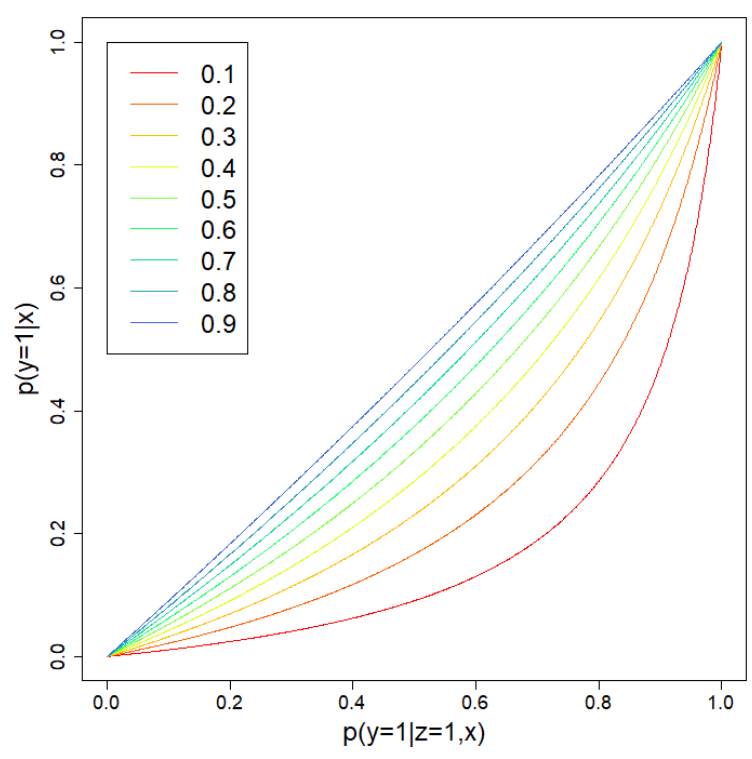
(cid:12) (cid:12) Figure 1. Relationship between the desired probability p ( y = 1 (cid:12) x ) and the probability based on a CC Figure 1. Relationship between the desired probability (cid:1868)(cid:4666)(cid:1877) = 1|(cid:1876)(cid:4667) and the probability based on a CC (cid:12) (cid:12) sampling approach p ( y = 1 (cid:12) z = 1, x ) . Assuming p 1 = 1, results are shown separately for di ff erent sampling approach (cid:1868)(cid:4666)(cid:1877) = 1|(cid:1878) = 1,(cid:1876)(cid:4667) . Assuming (cid:1868) (cid:2869) = 1 , results are shown separately for different rates of sampling the control cases (i.e., p 0 , see figure legend). The mathematical expression for this rates of sampling the control cases (i.e., (cid:1868) (cid:2868) , see figure legend). The mathematical expression for this relationship is given by Equation relationship is given by Equation 11.